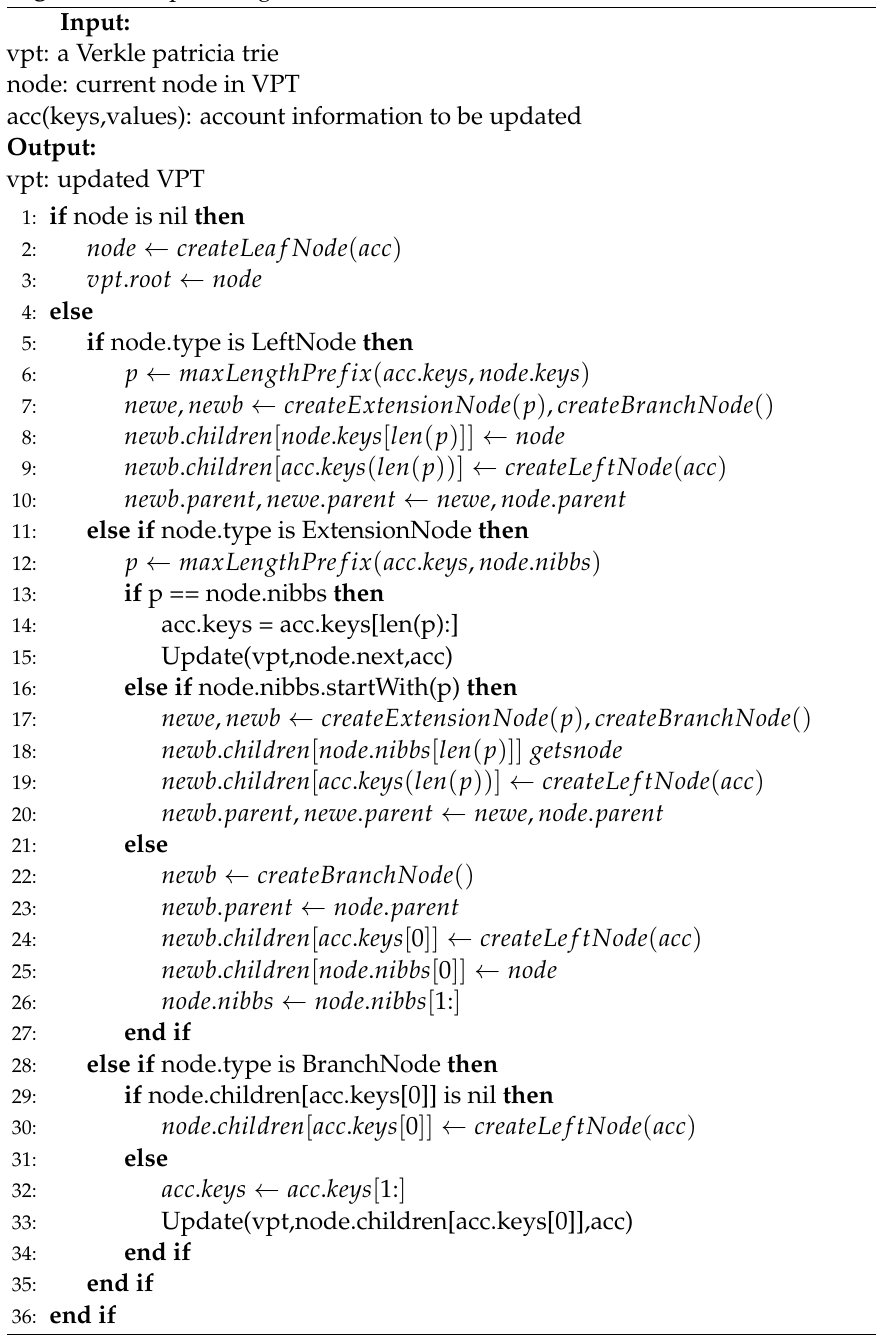
Algorithm 1 Update algorithm of